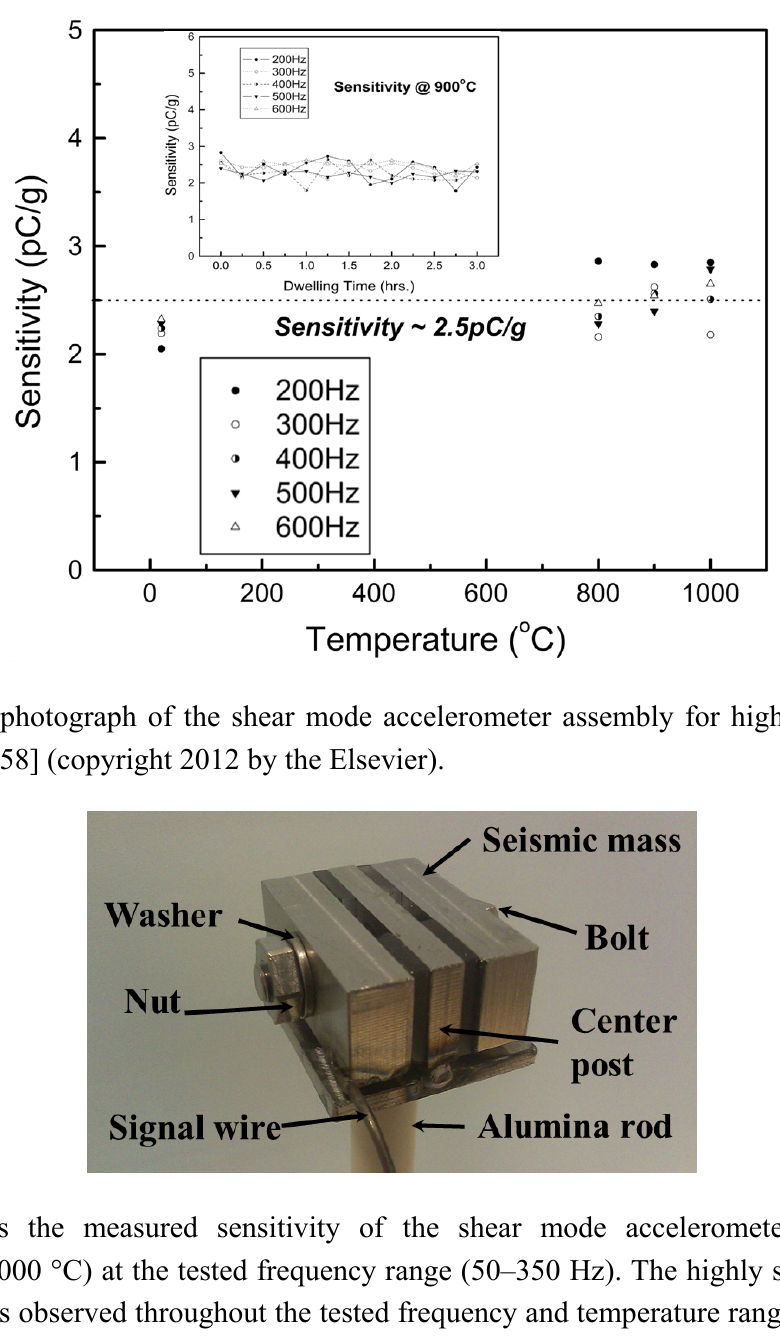
Figure 2. The measured sensitivities of the YCOB accelerometer as a function of temperature up to 1,000 °C with a frequency range of 100–600 Hz. The small inset shows the measured sensitivities as a function of dwell time at 900 °C for 3 h [57] (copyright 2010 by the American Institute of Physics).